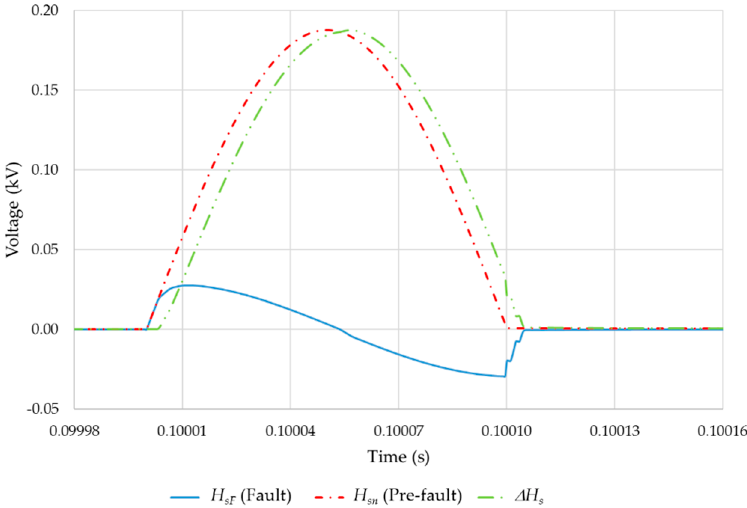
Figure 7. Comparison of a 5 kHz H s in pre-fault condition with the response H sF in fault condition (d = 0.5 km) and the di ff erence ∆ H s .